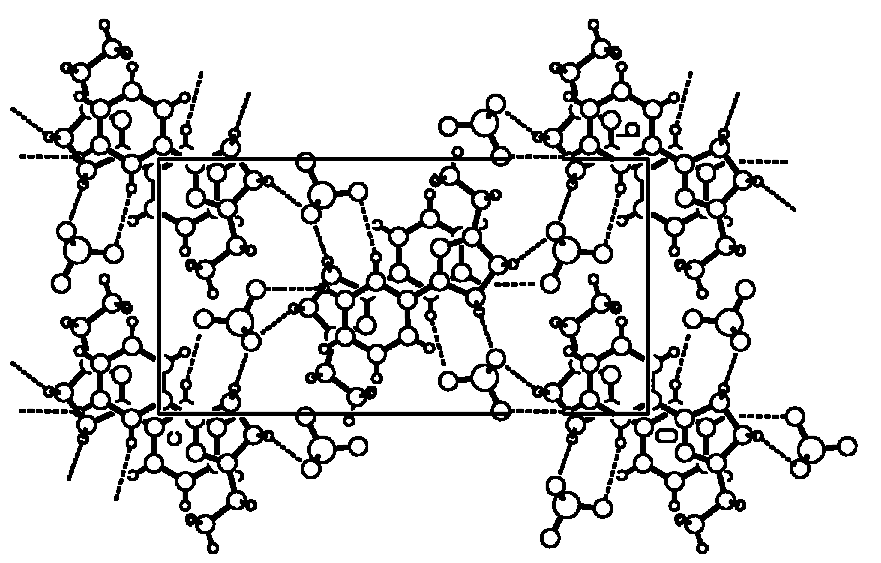
Fig. 3 Packing of the molecules down a axis and dashed lines represent the hydrogen